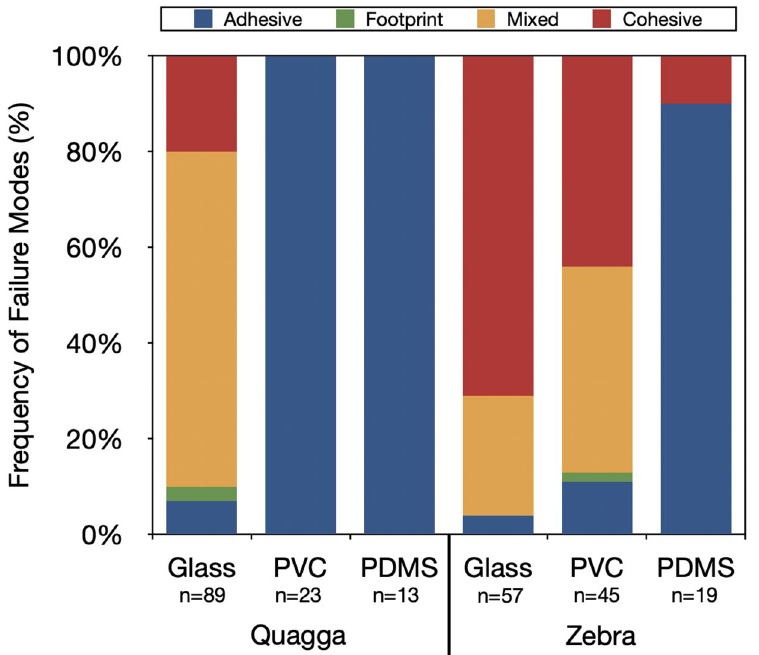
Figure 4. Single-plaque failure frequency of quagga and zebra mussel plaques on glass, PVC, and PDMS. n values correspond to the total number of plaques tested. Adhesive failure refers to a complete detachment of the plaque where no residue remains on the surface. Footprint failure entails a partial adhesive failure, where an adhesive residue is left behind. Cohesive failure is characterized by a failure occurring in the structural elements of the byssus (i.e. thread, thread-plaque junction, within the plaque). Mixed failure represents a partial footprint and adhesive failures.